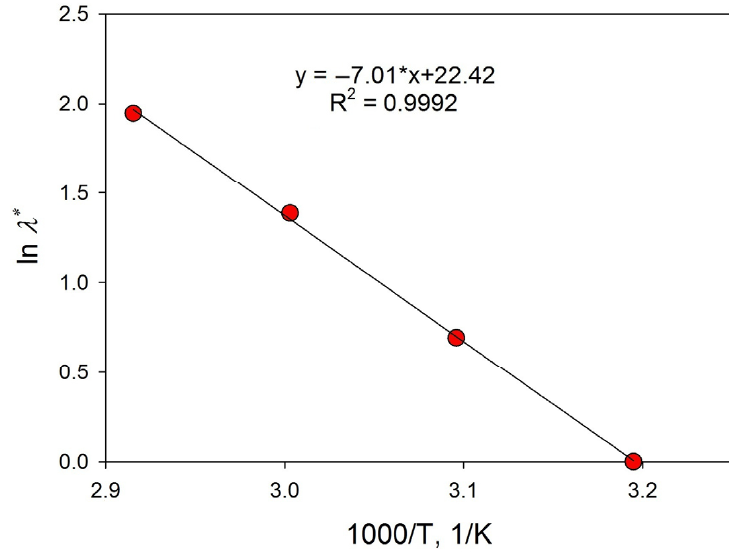
Figure 9. Arrhenius diagram for the catalyst Pd(0)/HPS.